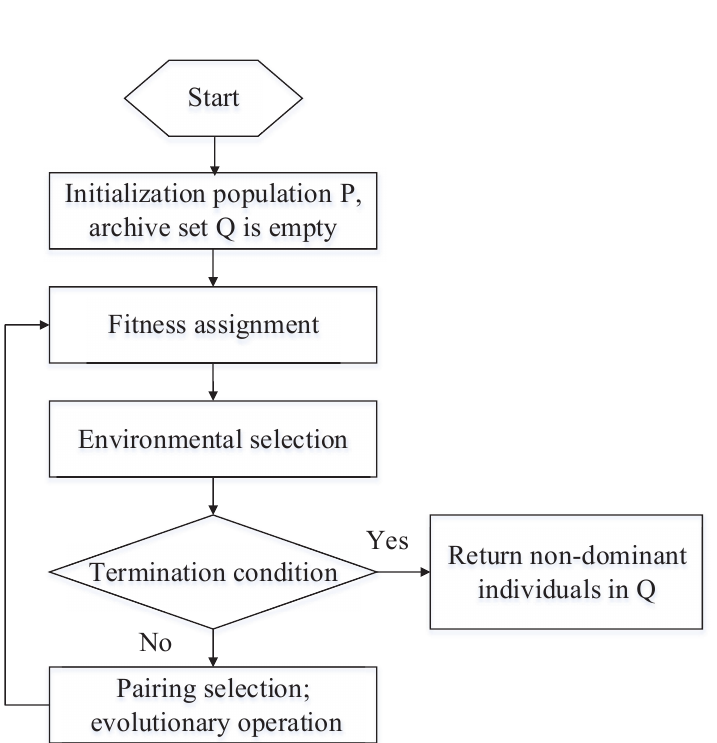
Figure 1. The description of the SPEA2 algorithm.